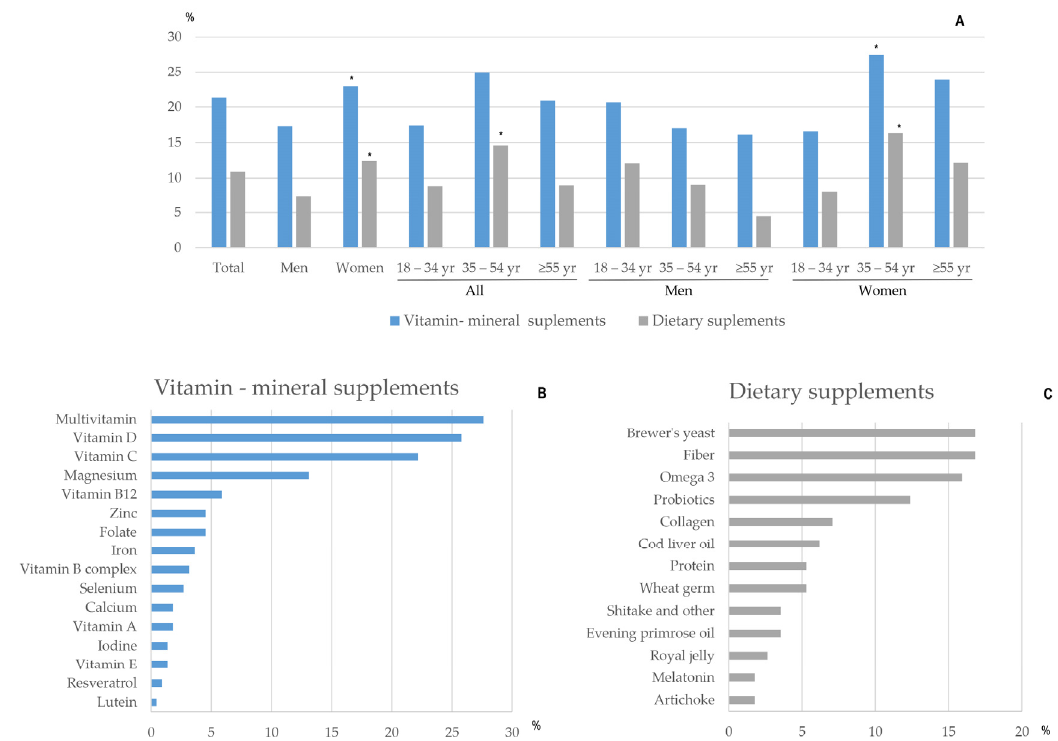
Figure 1. Consumption of vitamin–mineral supplements and dietary supplements during confinement in Spain: ( A ) Per- centage of consumers by gender and age; ( B ) Most frequently consumed vitamin and mineral supplements; ( C ) Most frequently consumed dietary supplements. * p < 0.05.